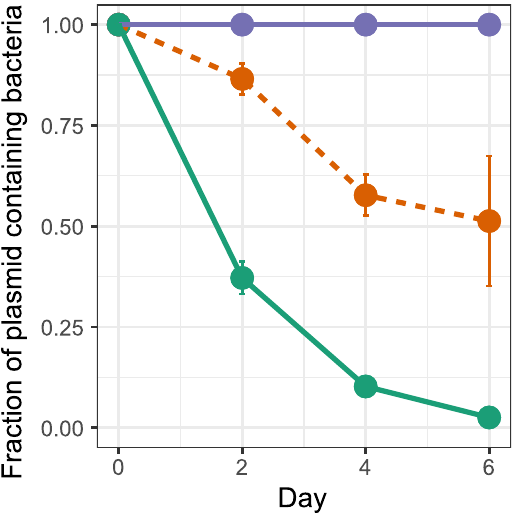
Figure 4. Persistence of the ancestral plasmid pBP136Km in the wildtype MR-1 ( ) and in the Δ fur mutant ( ) compared to the evolved clone L4-1 ( ). Each point is the mean of 3 individual replicates and the error bars show the standard deviation. The plasmid population dynamics model previously described 29, 34, 35 was used to determine if the persistence dynamics of two bacteria-plasmid pairs where similar or not (see Materials and Methods and SI).